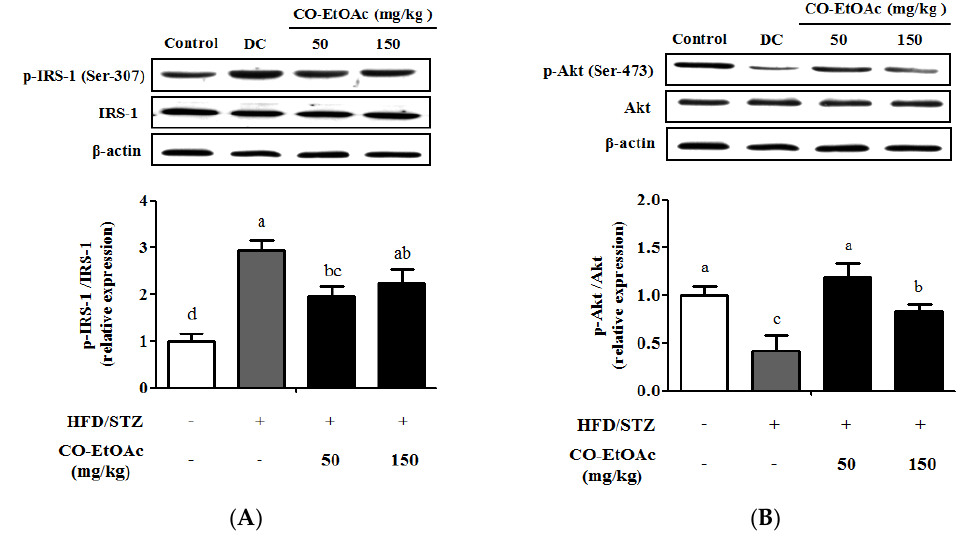
Figure 2. Effects of CO ‐ EtOAc on the regulation of insulin receptor ‐ mediated signaling. Relative protein levels of hepatic: ( A ) IRS ‐ 1 (phosphorylated IRS ‐ 1 at Ser ‐ 307 and total IRS ‐ 1); and ( B ) Akt (phosphorylated Akt at Ser ‐ 473 and total Akt) were detected by Western blot analysis. Data are represented as mean ± SEM ( n = 8–10). Values with different letters are statistically different ( p < 0.05) by analysis of variance (ANOVA) followed by Duncan’s multiple range tests. Relative expression values are expressed as folds of the control group, which is set as 1.